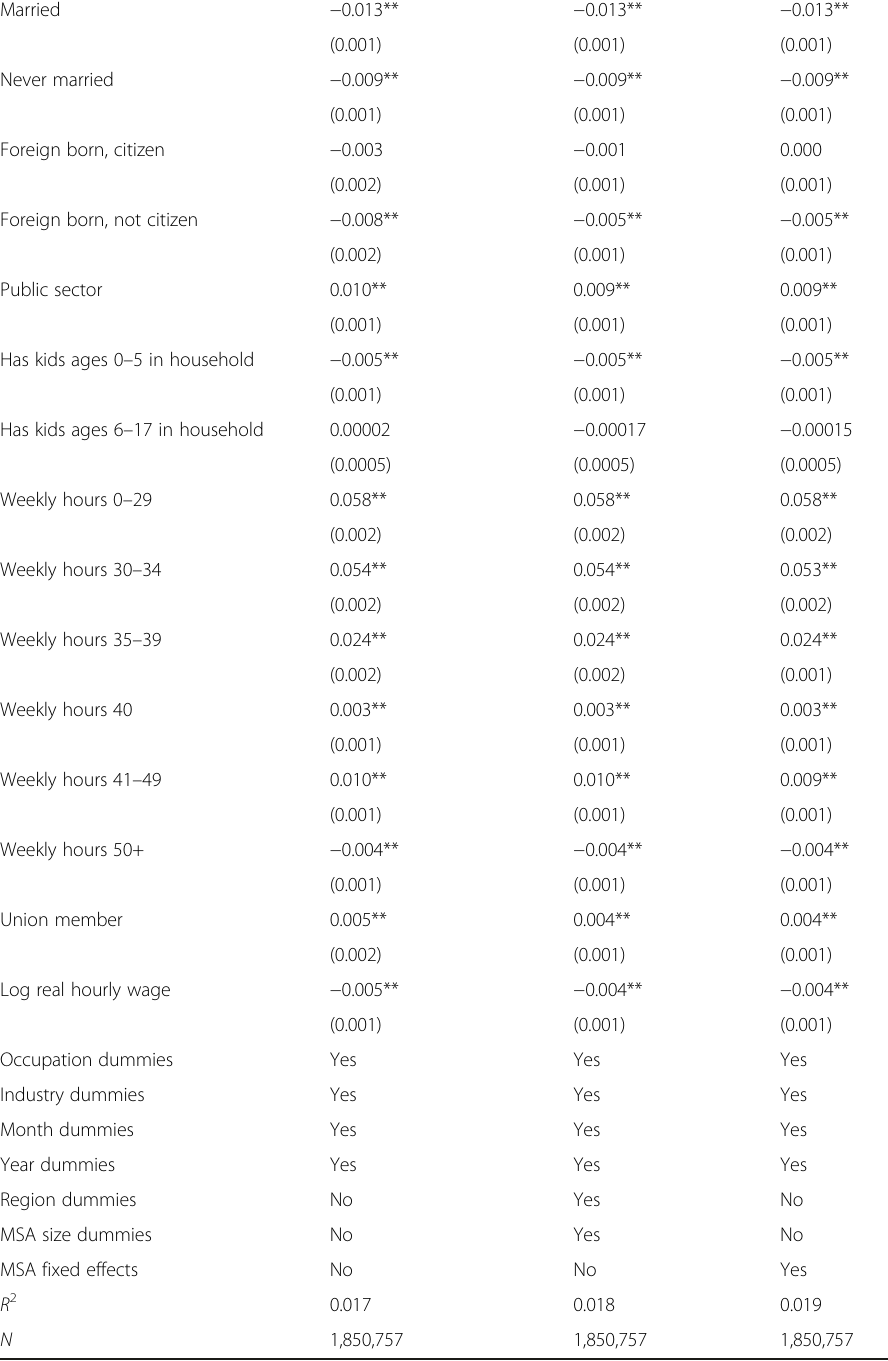
Table 10 Unemployment effects on multiple job holding, full coefficient results